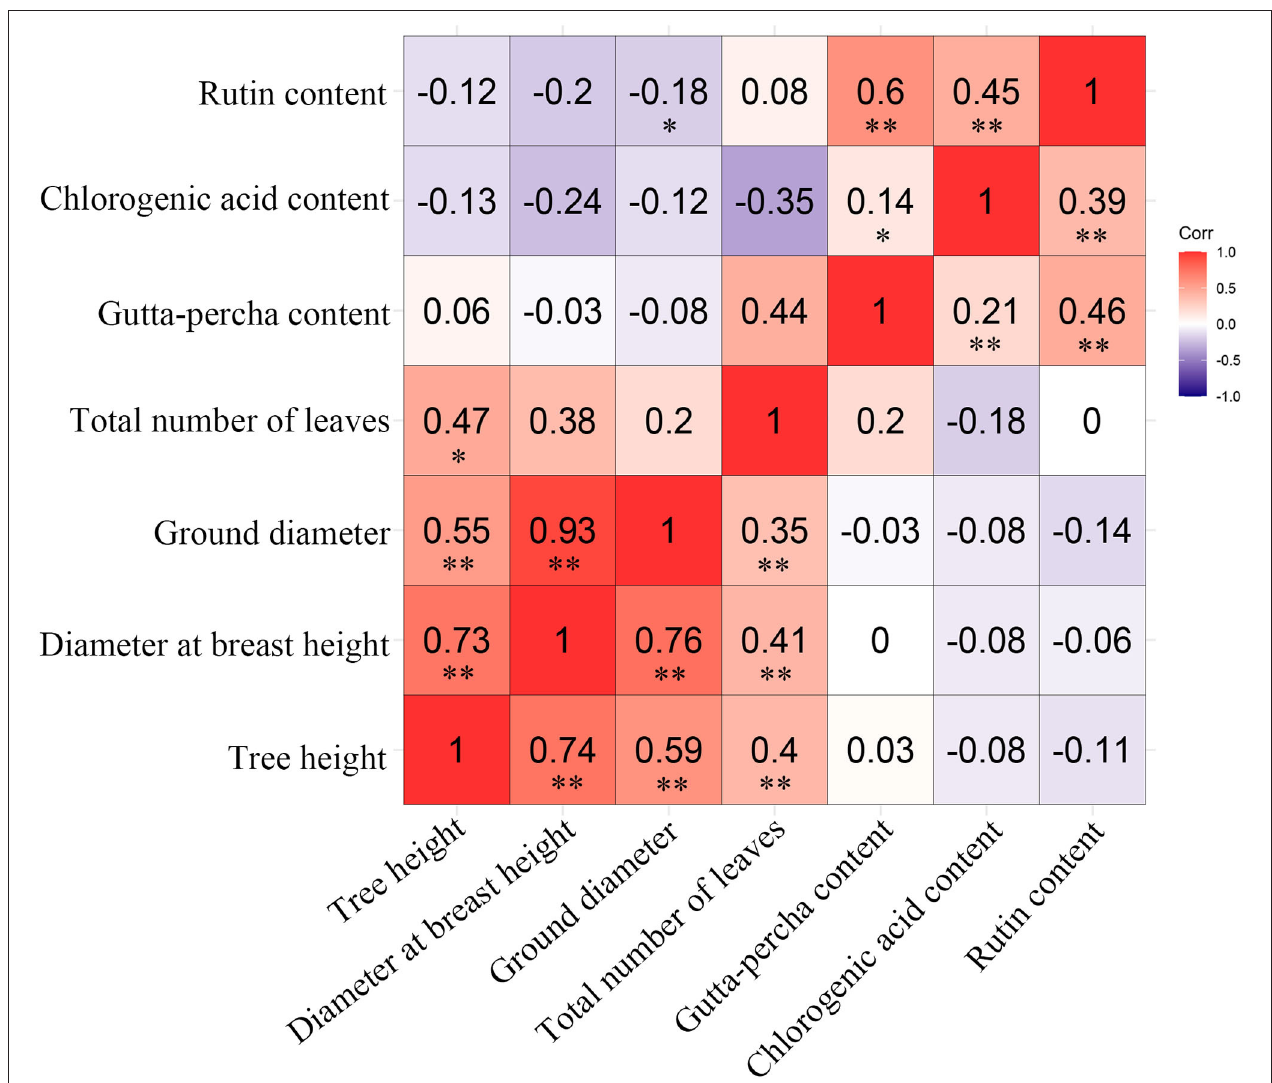
FIGURE 5 | Genetic (above diagonal) and phenotypic (below diagonal) correlations among traits. “**” and “*” represent a very significant difference ( P < 0.01) and a significant difference ( P < 0.05), respectively.